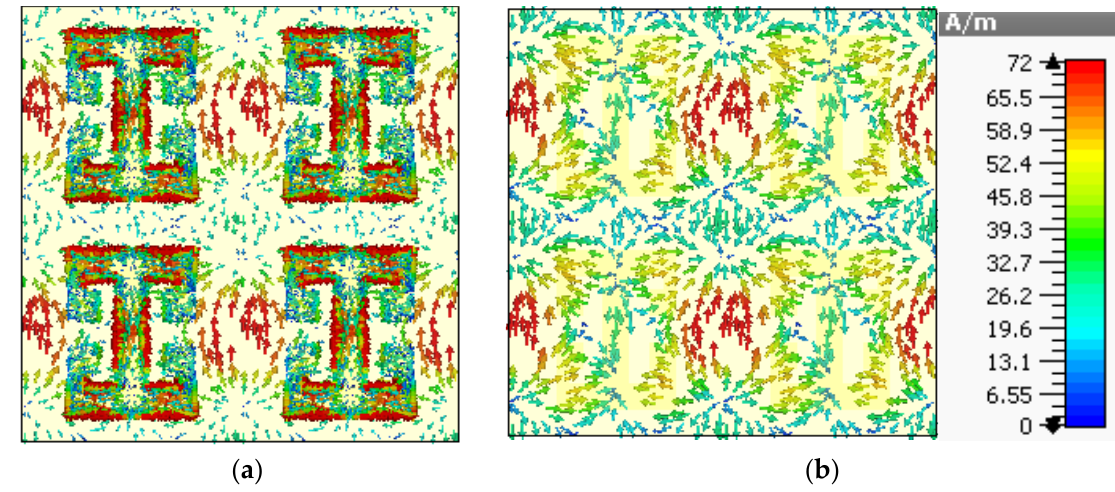
Figure 6. Surface current density for 28.3 GHz ( a ) top metasurface ( b ) bottom surface.